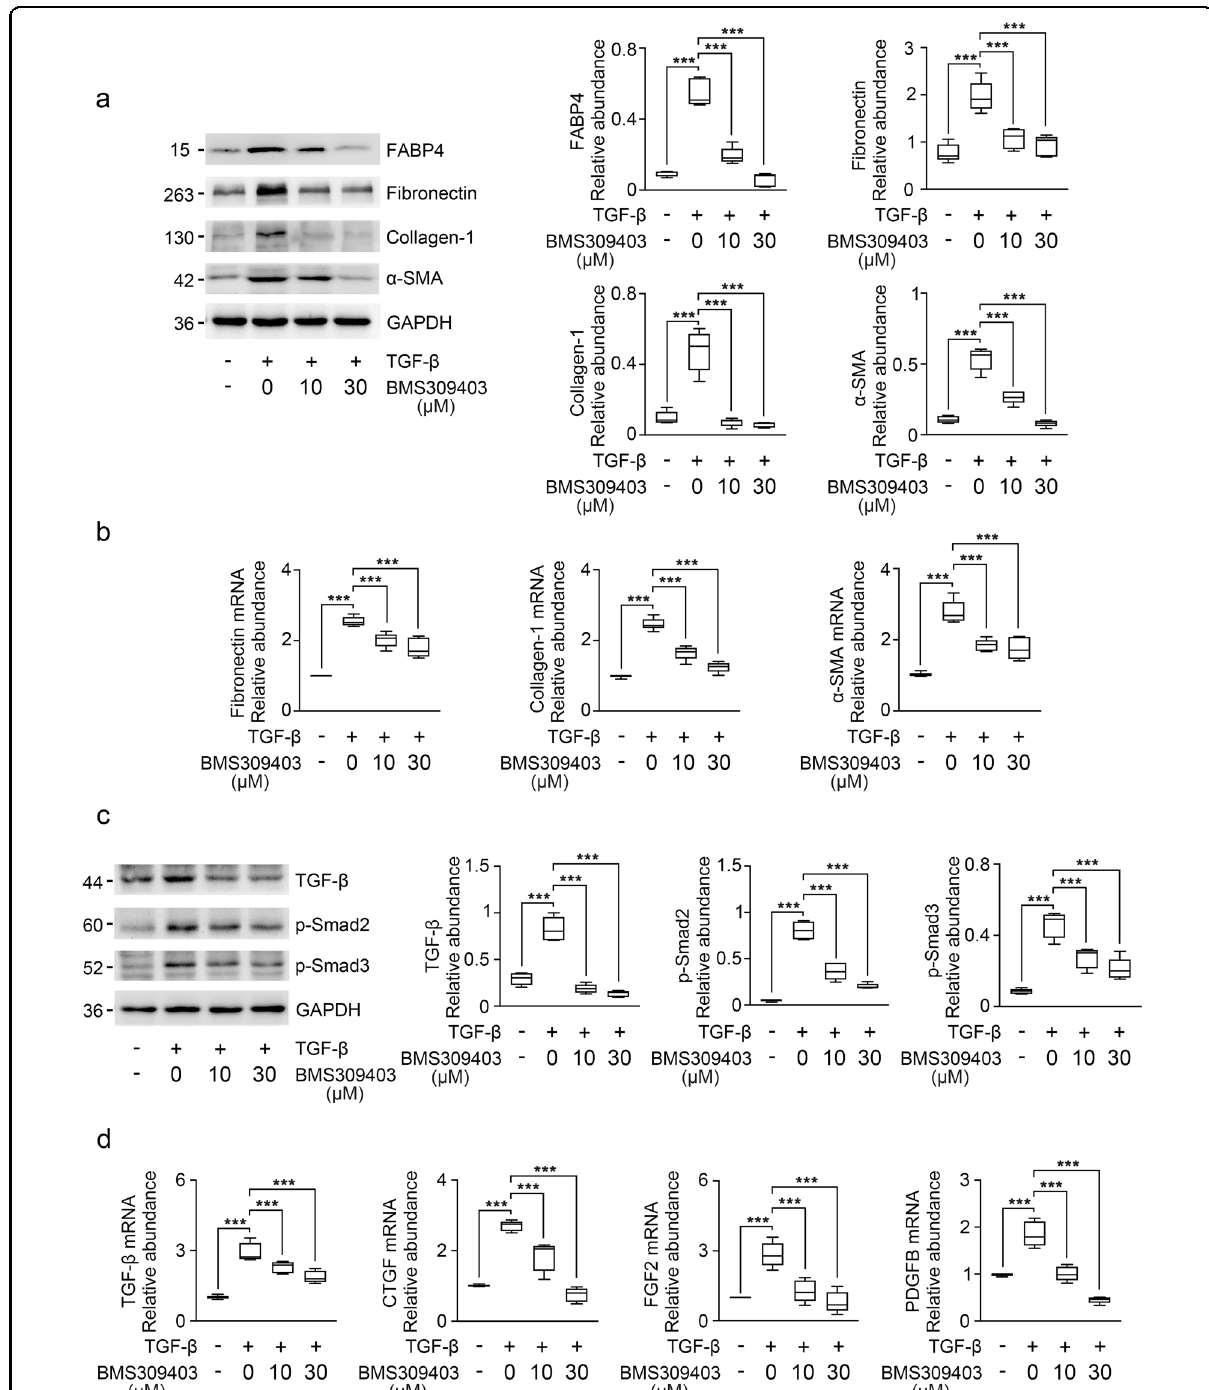
Fig. 3 BMS309403 decreased the expression of fi brosis marker in TGF- β -treated HK-2 cells via inhibiting TGF- β /Smad pathway. a Western blot of HK-2 cell lysates for FABP4, fi bronectin, collagen-I, and α -SMA expression. GAPDH sets as loading control. b RT-qPCR for fi bronectin, collagen-I, and α -SMA transcripts normalized to Gapdh in HK-2 cells. c Western blot and band intensity quantitation for TGF- β , p-Smad2, and p-Smad3 in HK-2 cells. Blots were stripped and reprobed for GAPDH. d RT-qPCR for TGF- β , CTGF, FGF2, PDGFB transcripts normalized to Gapdh in total RNA extracts of HK-2 cells from DMSO- or BMS309403-treated normal and TGF- β -treated cells. These data were calculated from three independent experiments. *** P <